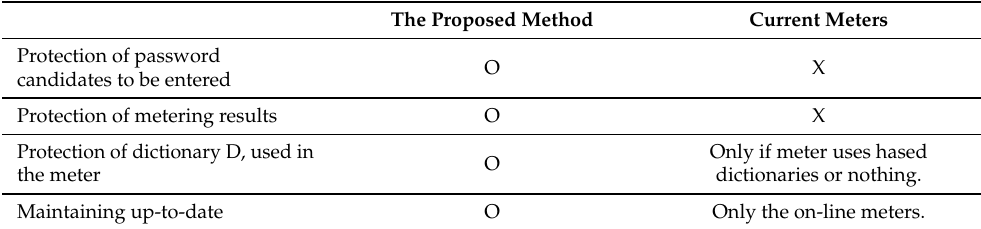
Table 9. Security Properties of the proposed method in contrast to current